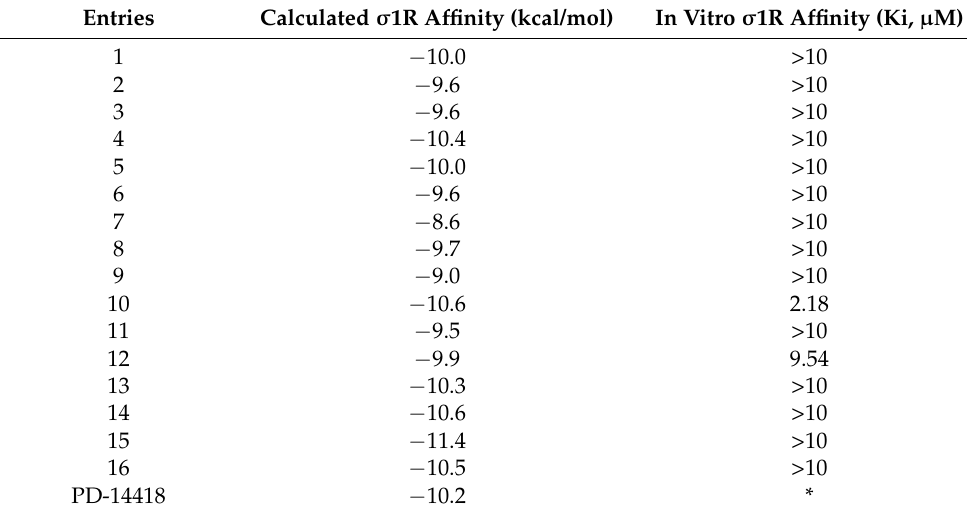
Table 4. Modeled (kcal/mol) versus in vitro ( µ M) binding affinity values. * PD144418 is a selective and high affinity (K i = 0.08 nM) σ 1R ligand